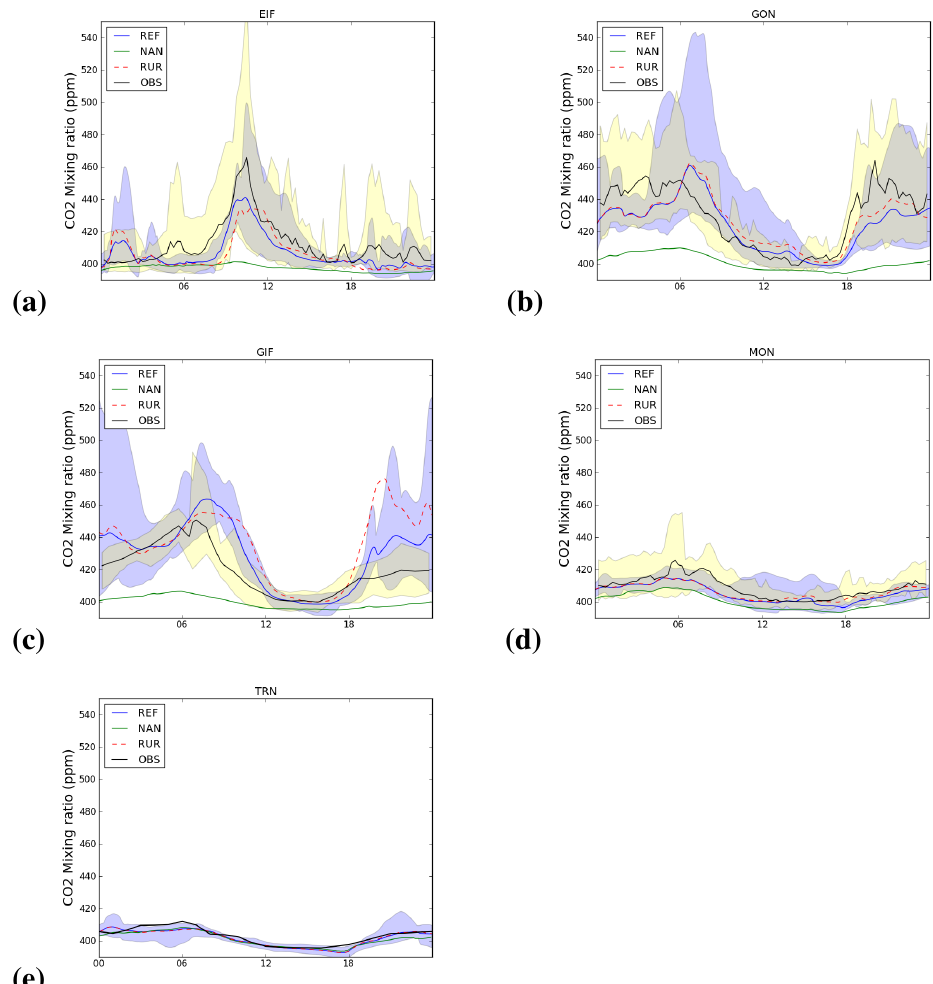
Fig. 10. Mean temporal evolution (over 6 days) of the CO 2 mixing ratios (in ppm) measured (black line) and predicted with REF (blue line), RUR (red line) and NAN (green line) simulations at EIF (a) , GON (b) , GIF (c) , MON (d) and TRN (e) . The yellow area is between the minimum and maximum of the measurements, and the blue area between the minimum and maximum of the REF simulation.